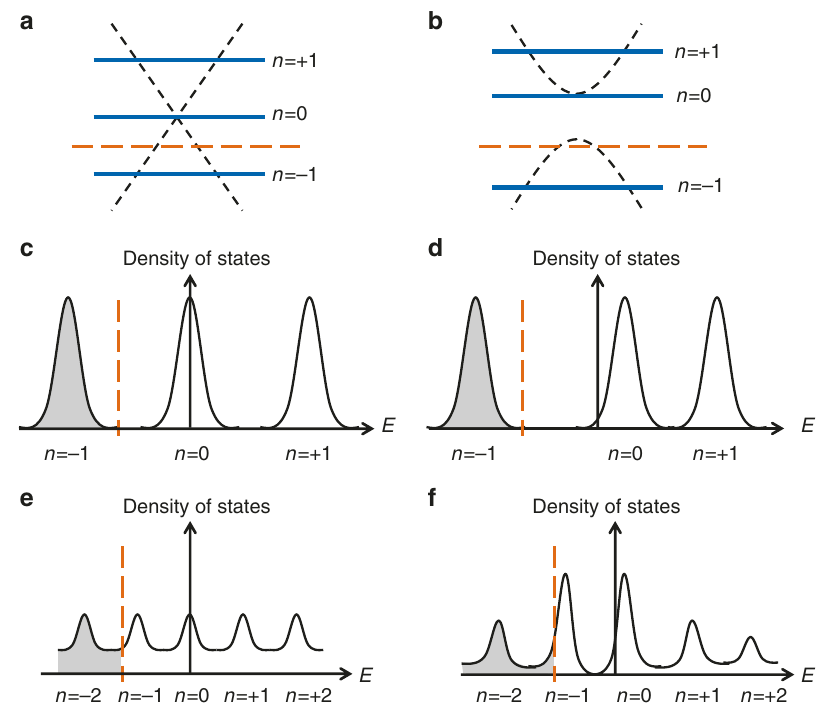
Fig. 3 The delayed Landau level hybridization model. a , c , e and b , d , f schematically show the Landau Level (LL) diagram before/after Co cluster deposition, respectively, during Hall quantization. The orange dashed lines indicate the Fermi energy. Under a magnetic fi eld, the deposited Co clusters induce a Zeeman-like gap in the Dirac cone of the top surface. The zeroth LL is shifted to the top of the Zeeman gap ( b ), while the bottom surface is unchanged, similar to the case for clean devices ( a ). This makes no signi fi cant difference at a suf fi ciently high fi eld ( c , d ). At a medium fi eld, it leads to the observed anomalous quantization trajectory ( e , f ). The anomalous RGFD trajectory (Fig. 2c) is the result of the delayed LL hybridization (DLLH) of the top surface ( f